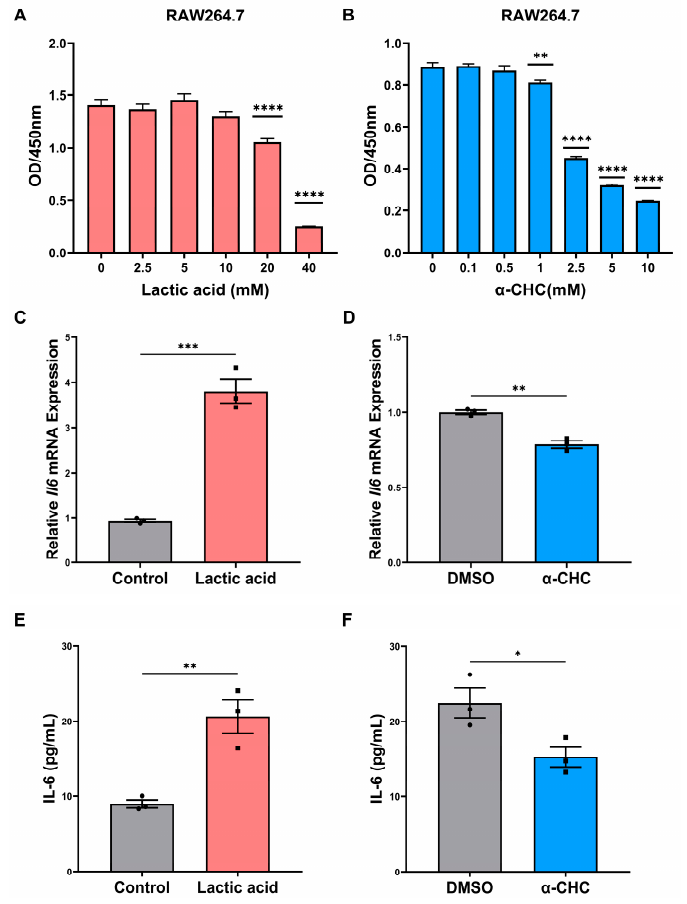
Figure 5. ENO1 orchestrates IL-6 secretion of macrophages via tumor cell-derived lactic acid. ( A , B ) CCK8 assay for cell viability of macrophages treated with indicated doses of lactic acid ( A ) or α -CHC ( B ) with TCM for 24 h. ( C , D ) RT-qPCR analysis of the mRNA levels of IL-6 in macrophages treated with 10 mM lactic acid ( C ) or 1mM α -CHC ( D ) with TCM for 24 h. ( E ) ELISA for detection of IL-6 protein levels in CM from macrophages treated with TCM without or with 10 mM lactic acid for 24 h. ( F ) ELISA for detection of IL-6 protein levels in CM from macrophages treated with TCM without or with 1 mM α -CHC for 24 h (1%DMSO in TCM was used as a solvent control). Different symbols (circle/square) were used to represent the data points of independent biological repeated experiments. All data are displayed as mean ± SEM; n = 3; * p < 0.05, ** p < 0.01, *** p < 0.001 and **** p <